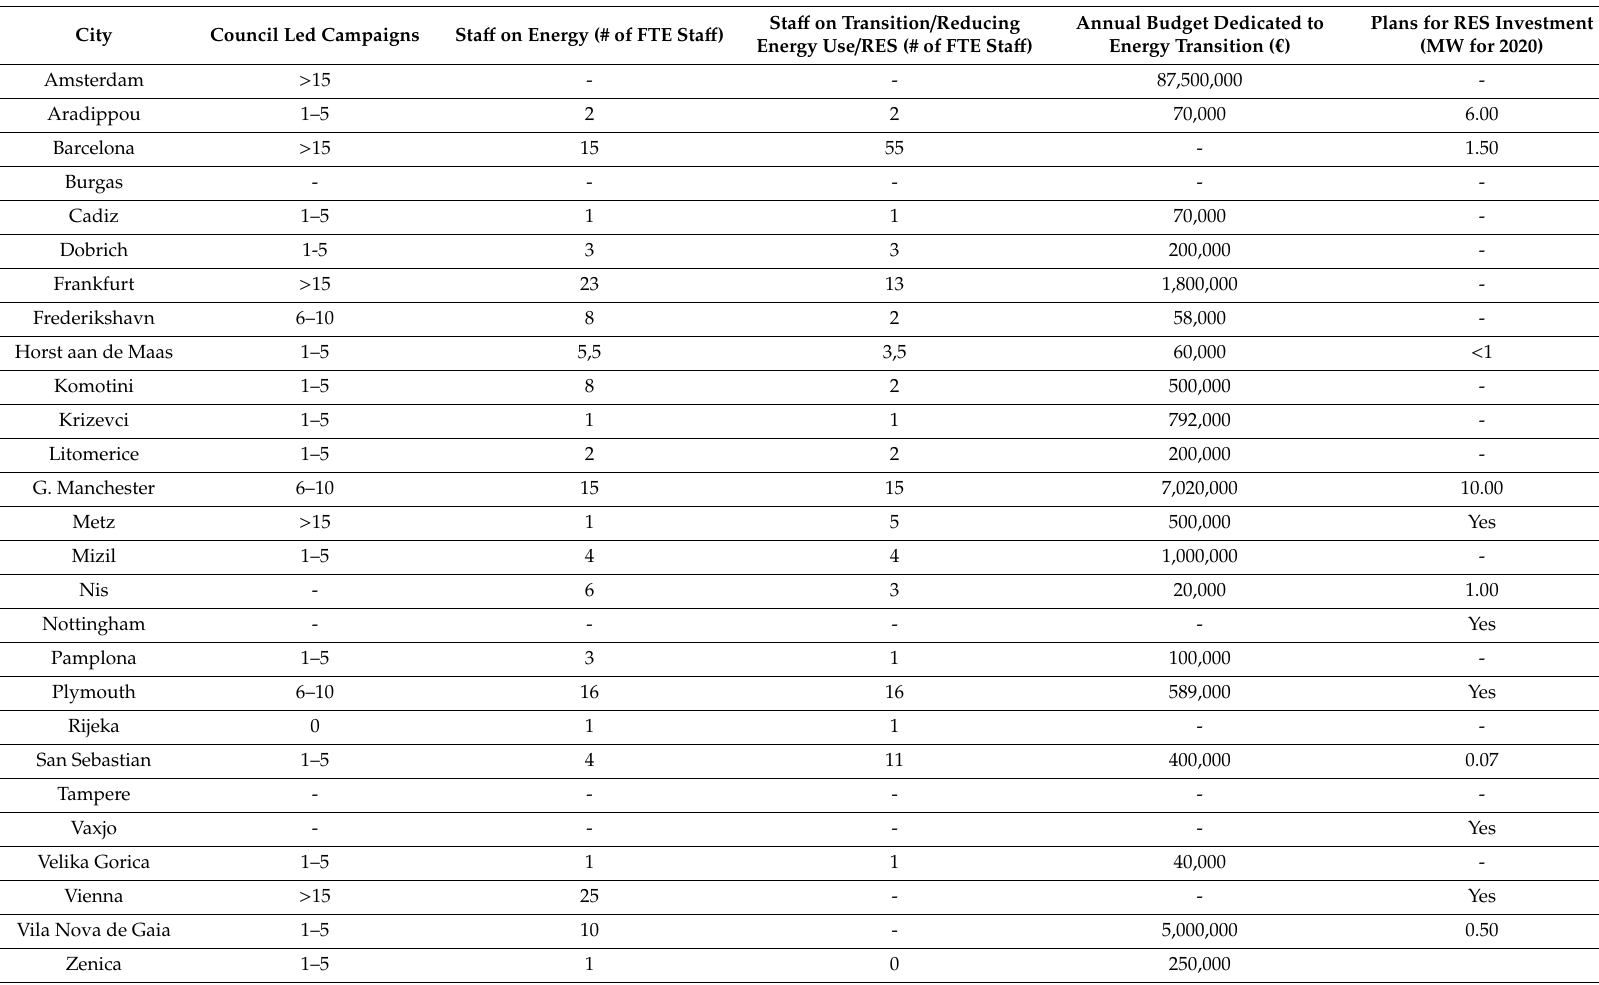
Table A3. Number of campaigns led by the council or cooperatives / citizens, sta ff on energy, sta ff on transition / reducing energy use or RES, budget dedicated to energy transition and plans for RES